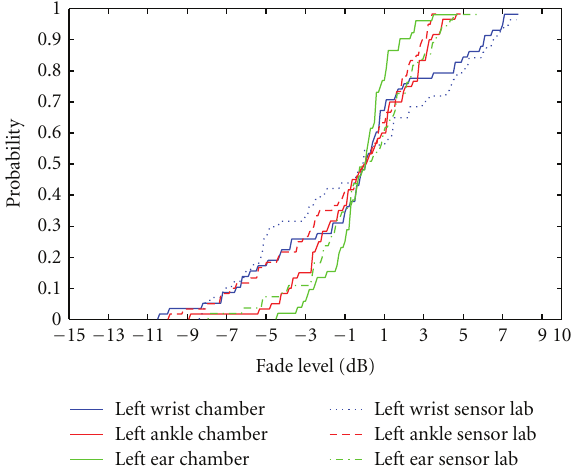
Figure 13: Comparison of level crossing rate (LCR) for three on- body channels as left wrist, left ankle, and left ear when subject was walking 5 steps ahead and back measured in the chamber and in indoor